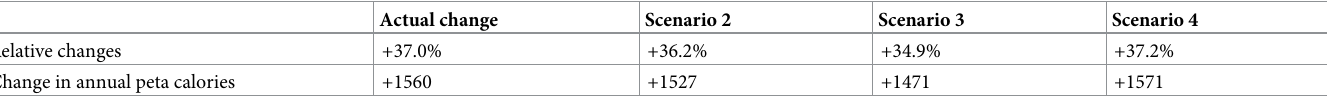
Table 3. Backcasting global changes between 1990 and